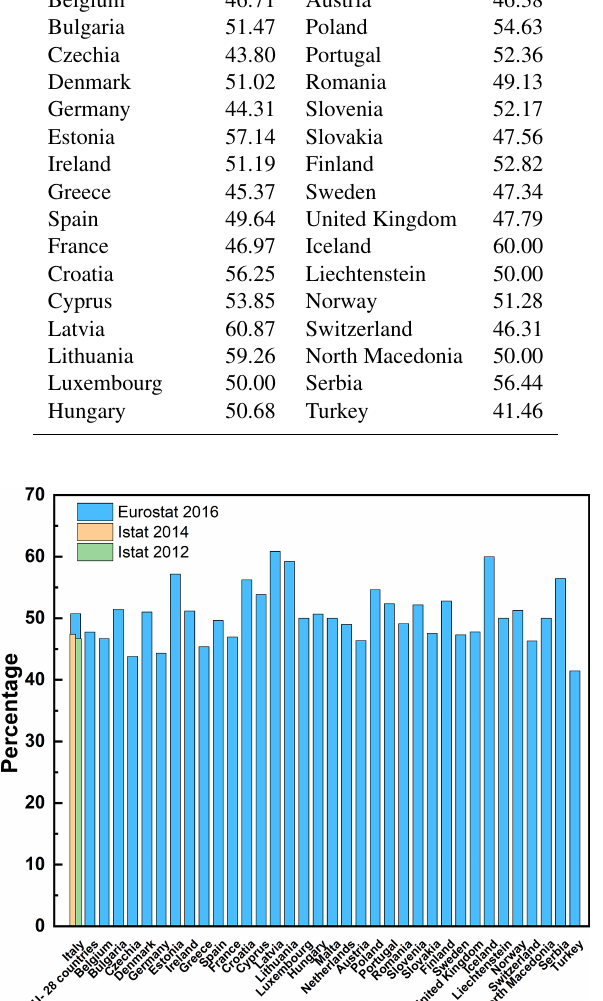
Figure 2. Percentages of female Ph.D. students in all disciplines in Europe and Italy in 2016 (source data: EUROSTAT, https://ec. europa.eu/eurostat/home?, last access: 31 October 2019). Data for